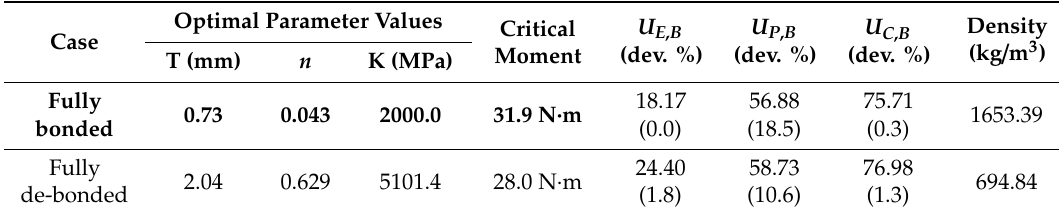
Table 4. Results of the beam model parameter